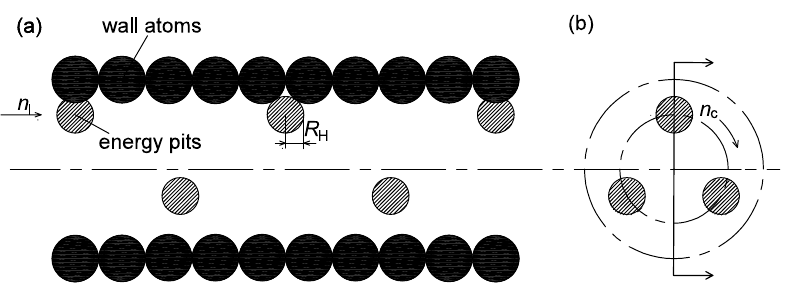
Figure 1. Illustration of the wood cell wall nanopore model and modelled sorption isotherms. ( a ) the cell wall substance and nanopores with an initial pore size distribution 𝜓 (cid:2869) ; ( b ) simulated sorption isotherms for different pore sizes 𝑑 (cid:3037) ; 𝜌 (cid:3050)(cid:3028) represents the adsorbed water density ( c ) cell wall pore size distributions 𝜓 (cid:3036) evolving with humidity; ( d ) the eventual wood water sorption isotherm simulated.